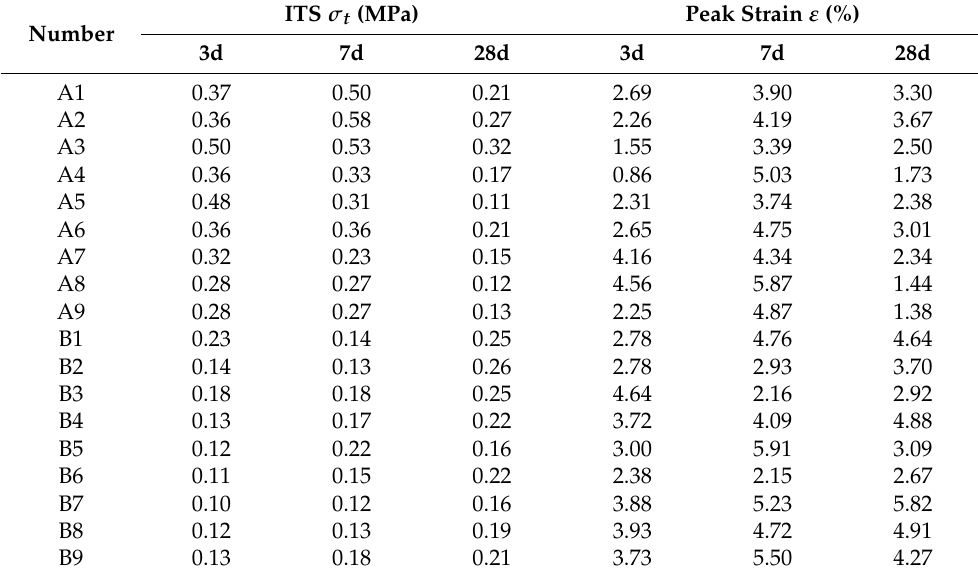
Table 5. ITS and peak tensile strain results of RSCPB (Group A) and CCPB (Group B).